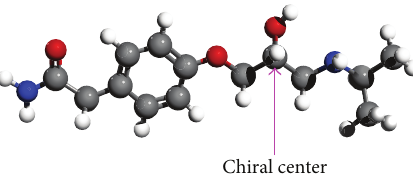
Figure 1: Molecular structure of atenolol. It could be a racemic mixture and the chiral center is at the C marked with an arrow. The red is O, the blue is N, and the dark gray is C, while the white is